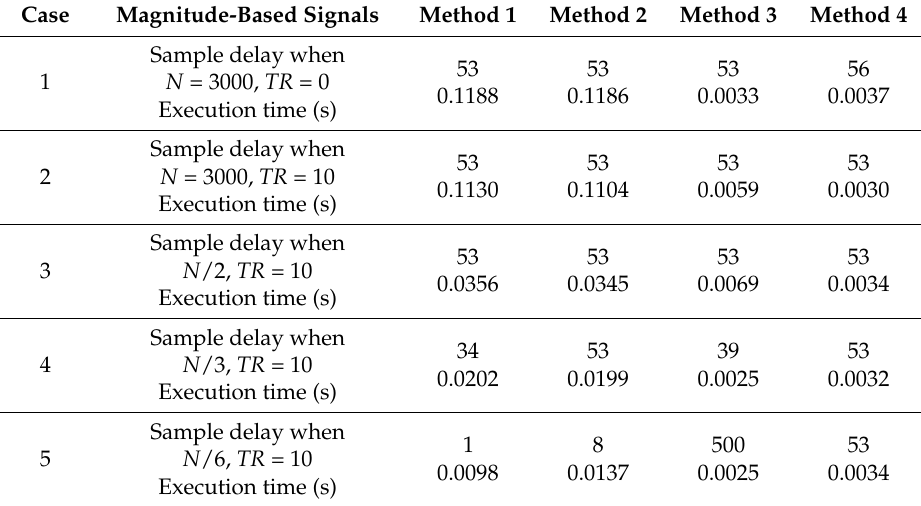
Table 2. Estimated sample delay and program execution time for a vehicle that traveled at 33.3 km/h (threshold as a TR -time mean of background noise).